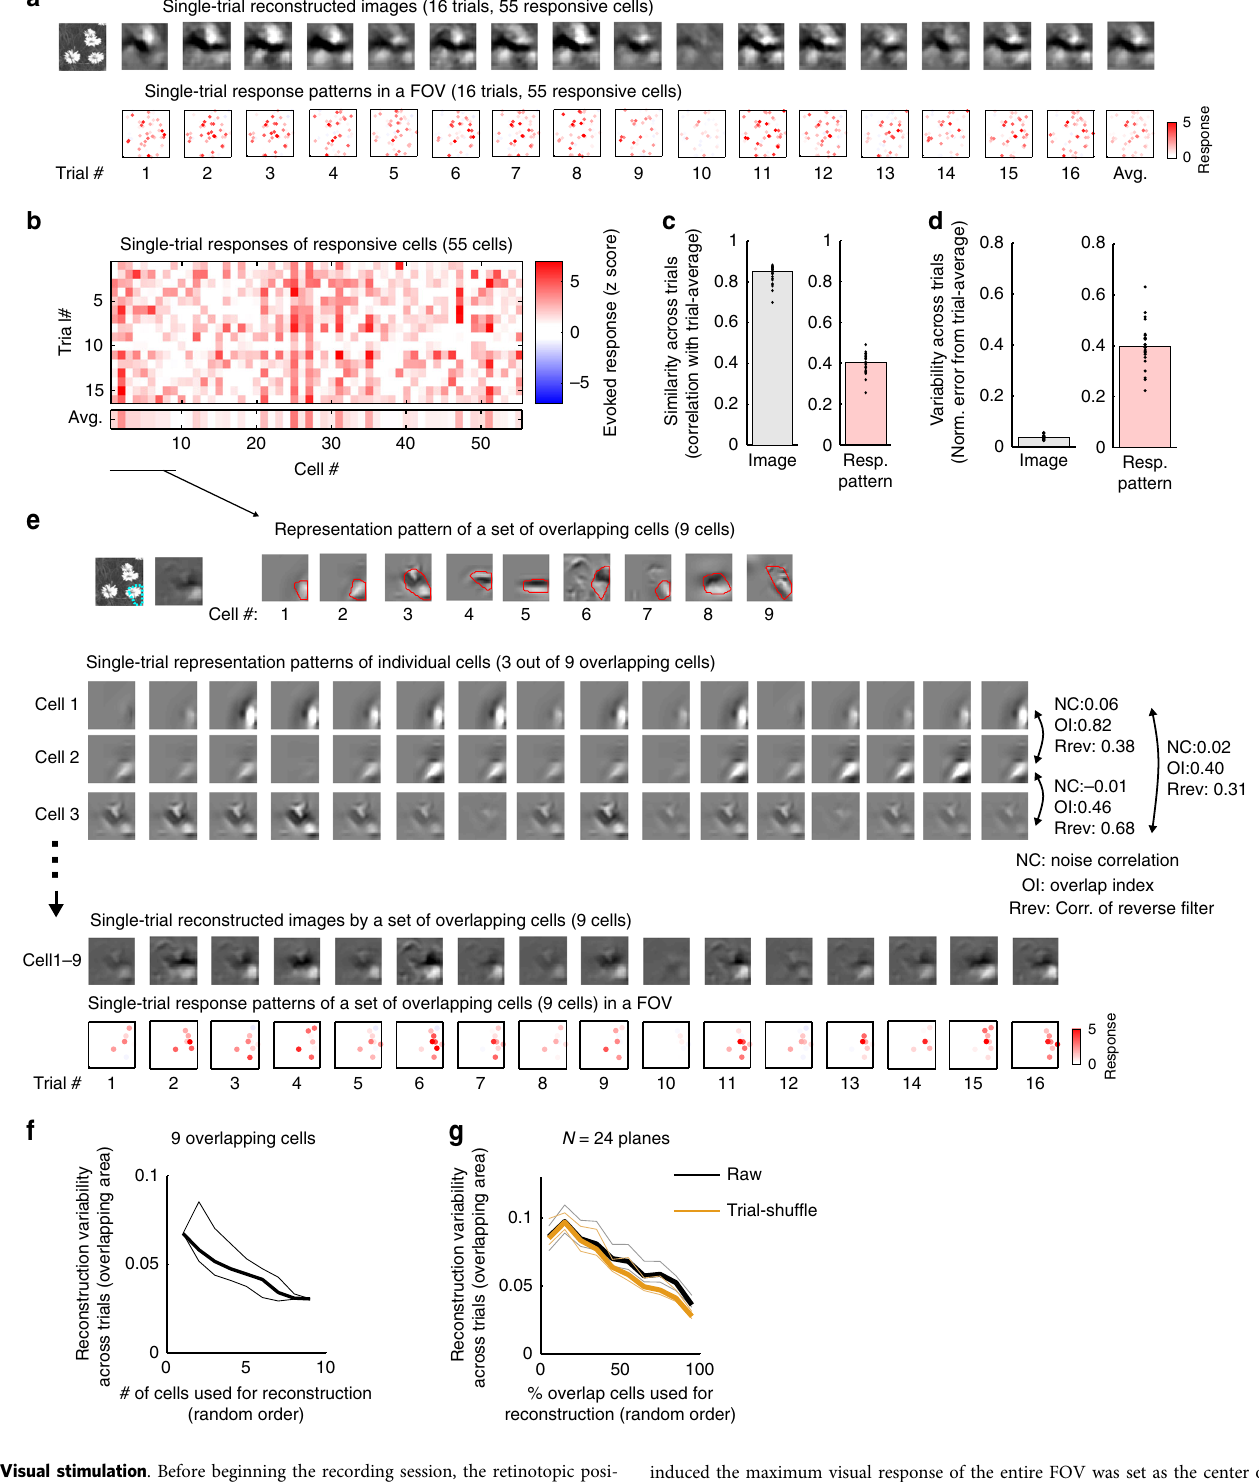
induced the maximum visual response of the entire FOV was set as the center of the retinotopic position of the FOV. A set of circular patches of greyscale, contrast-enhanced natural images (200 image types in main datasets, dataset 1) was used as the visual stimuli for predicting the response and reconstructing the natural image (256 intensity level, 60 degrees in diameter, 512 × 512 pixels, with a circular edge (5 degrees) that was gradually mixed to a gray background). Contrasts of natural images were enhanced (>90%). Original natural images were obtained from the van Hateren Natural Image Dataset (http://pirsquared.org/research/#van-hateren-database) 56 and the McGill Calibrated Color Image Database (http://tabby.vision.mcgill.ca/html/ welcome.html) 57 . Square image patches (512× 512 pixels) were obtained